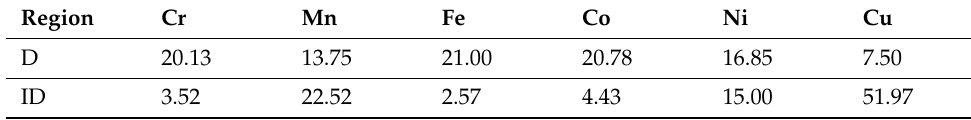
Table 1. Dendritic (D) and interdendritic (ID) compositions (at.%).